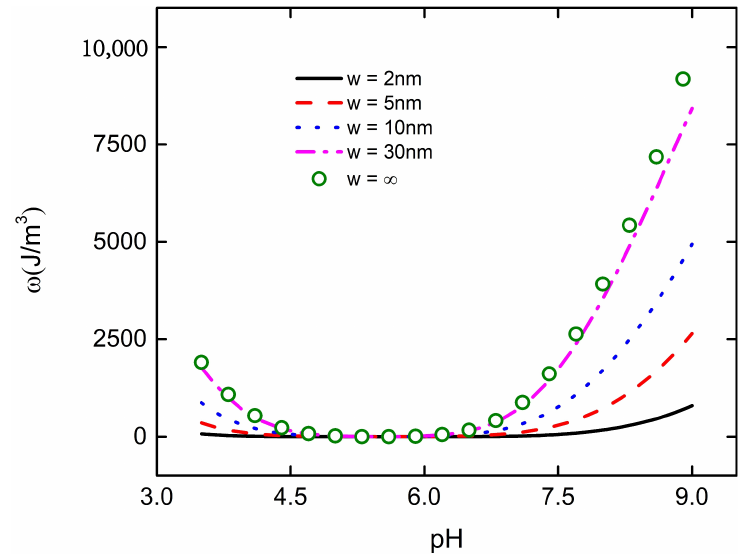
Figure 6. The curves of electric field energy density with pH in the PE brush layer at the bottom of nanoparticle with di ff erent distances between particle and plate at C KCl = 1